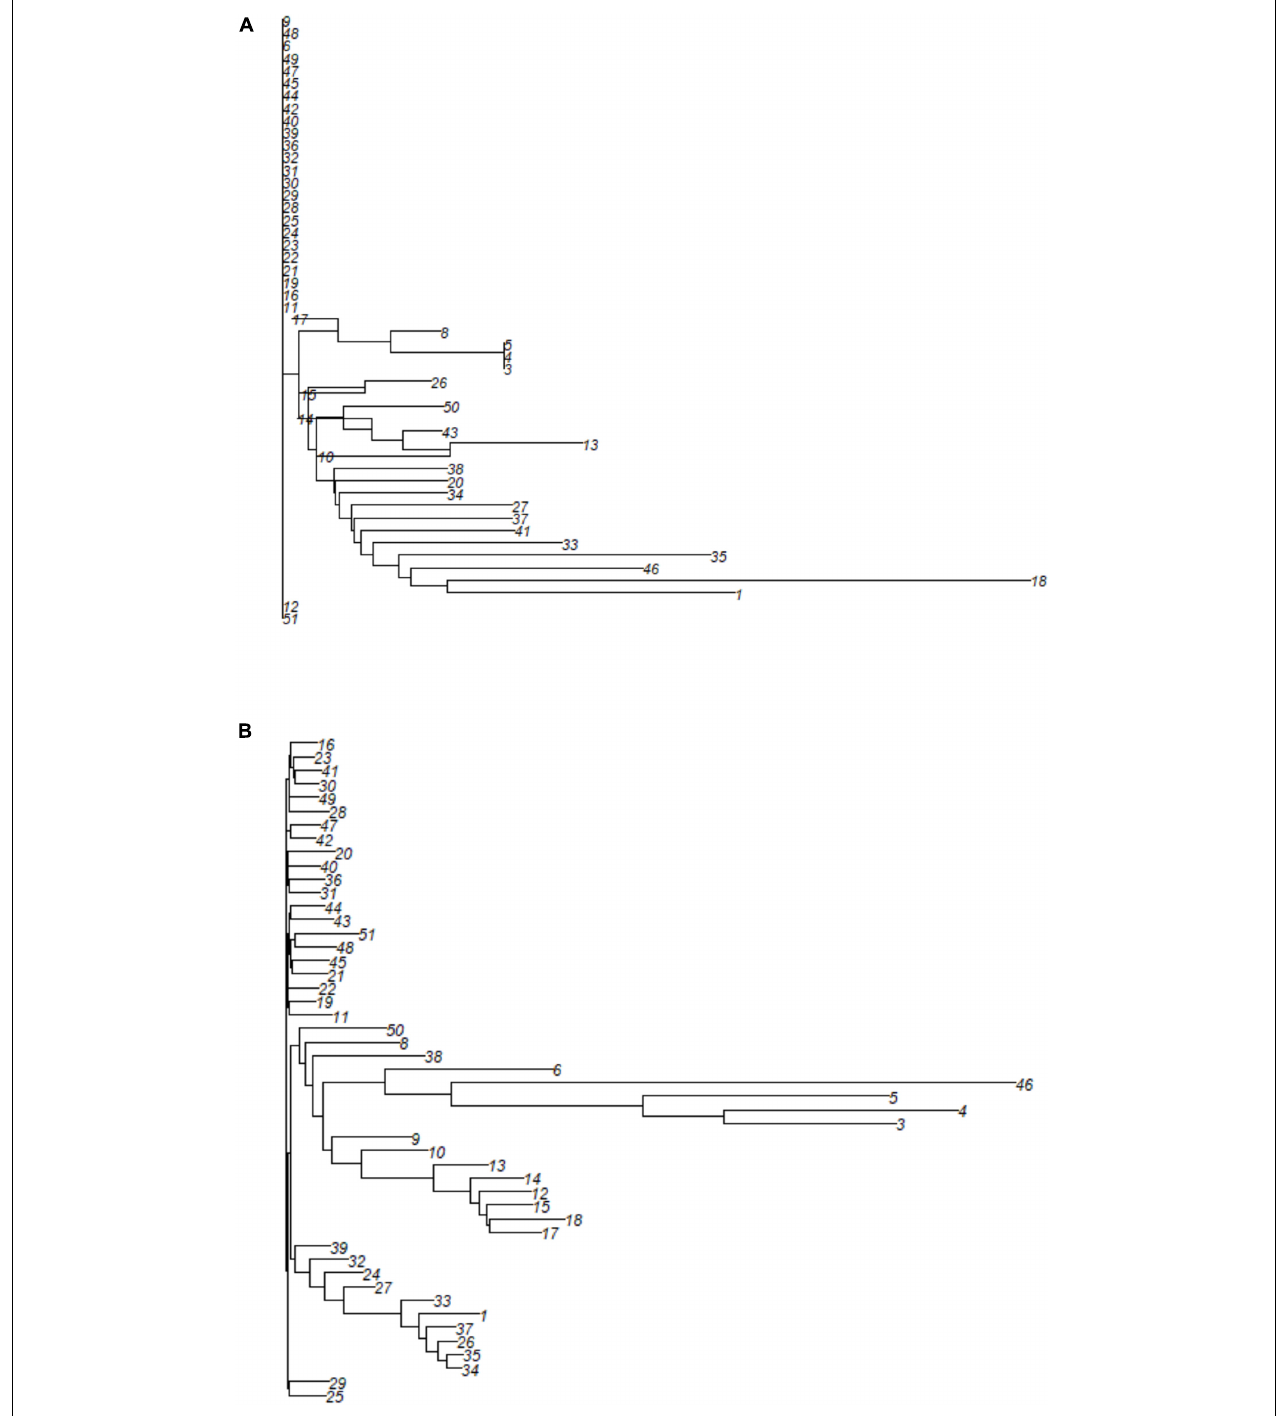
FIGURE 6 | A neighbor-joining cluster analysis based on (A) SNP and (B) SilicoDArT markers to group 49 M. argun individuals. For information on collection sites and generation categories, see the corresponding individual numbers in Supplementary Table 1 .